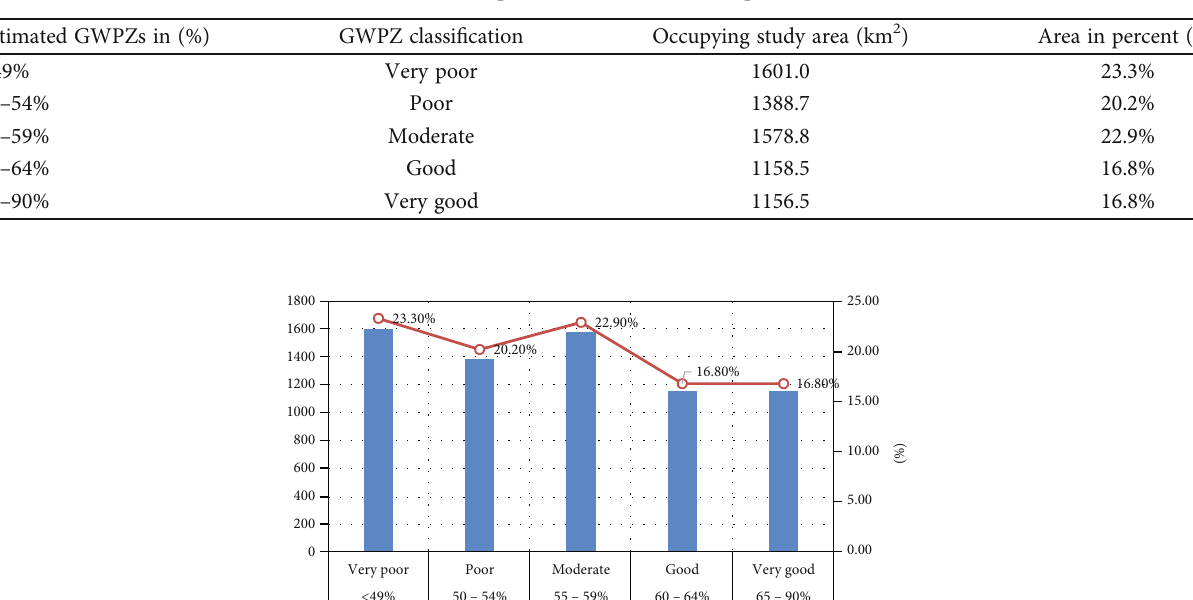
Table 5: Groundwater potential classes and their quantitative values.